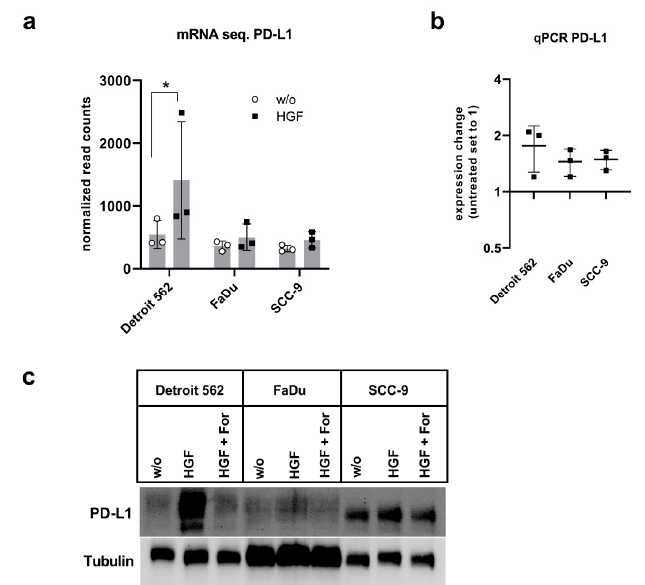
Figure 1. Hepatocyte growth factor (HGF) stimulation enhances programmed cell death protein 1 (PD-L1) concentration on mRNA and protein level. Three head and neck squamous cell carcinoma (HNSCC) cell lines (Detroit 562, FaDu, and SCC-9) were treated with 50 ng/mL HGF (HGF), 50 ng/mL HGF in combination with 0.5 µM foretinib (HGF + For) or remained untreated. After 16 h, RNA was isolated and subjected to mRNA sequencing ( a ) or was further processed to cDNA for qPCR ( b ). Additionally, cells were lysed after 48 h, and a Western blot with an antibody specific for PD-L1 was carried out ( c ). As a loading control blot was reprobed using an anti-tubulin antibody. *: adjusted p -value (from sequencing analysis) of 0.001 ( α is